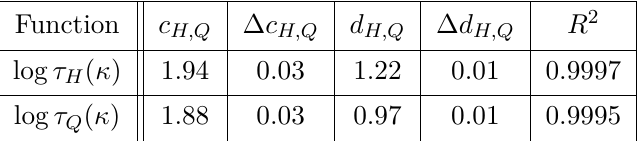
Table 9 . Fits of log τ H ( κ ) and log τ Q ( κ ) . The fitting functions c H ( κ − d H ) and c Q ( κ − d Q ) are shown in figure 8, and the fitted values are displayed in table 7 and in table 8 respectively. ∆ c and ∆ d denote the 95% -confidence intervals of the two coefficients. H,Q